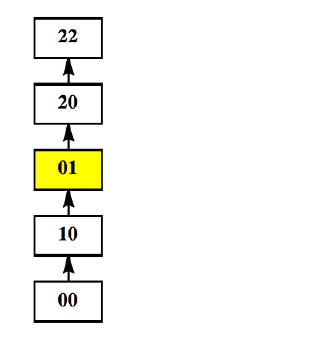
Figure 2 . G 2 nilpotent orbit Hasse diagram. The diagram is derived from Hilbert series inclusion relations, with the yellow node indicating a non-normal nilpotent